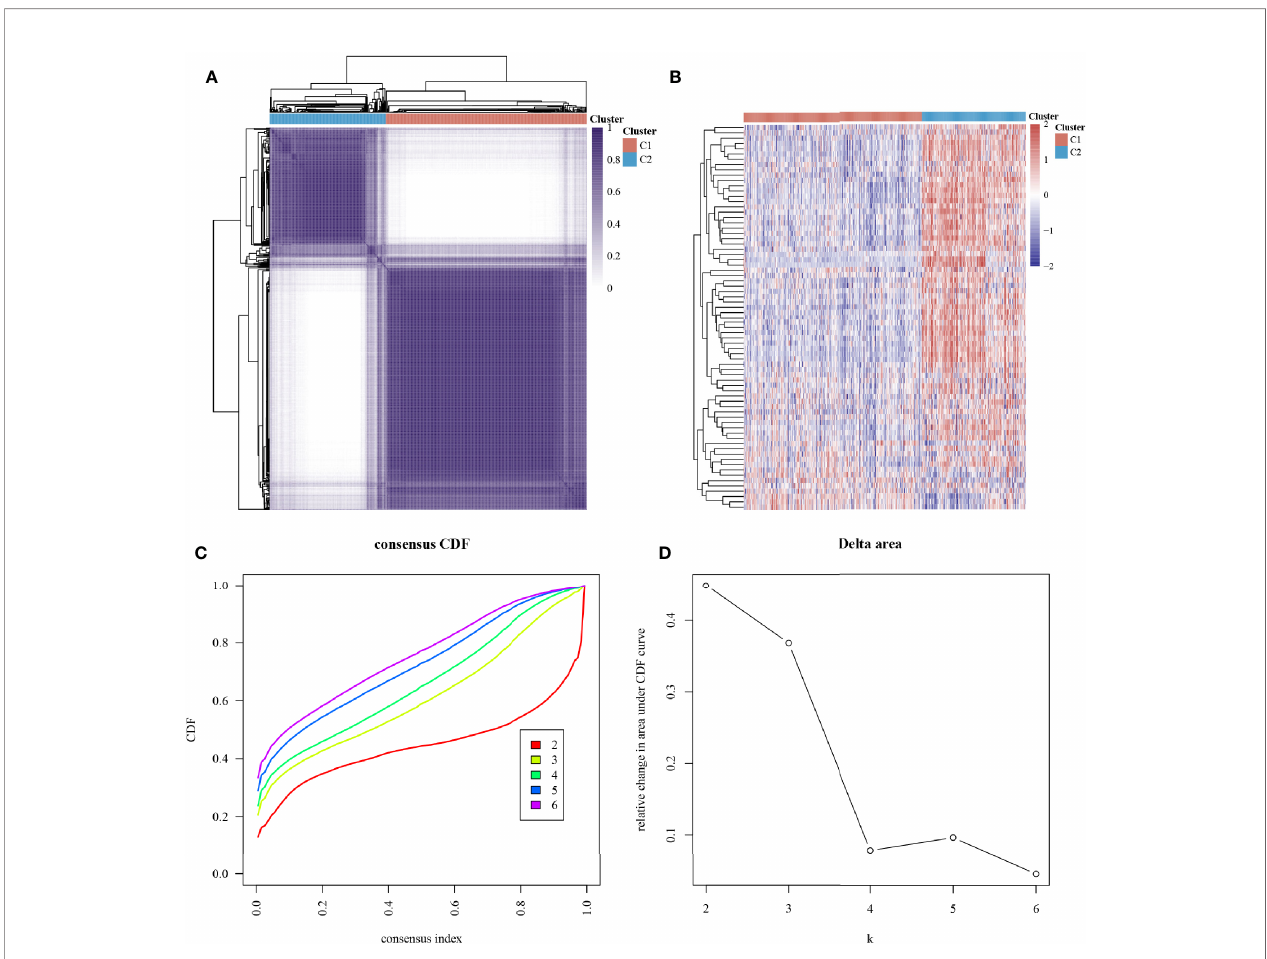
FIGURE 2 | Subtype grouping of 75 hypoxia-associated genes in the TCGA database glioma samples. (A) Consensus clustering matrix at K = 2, (B) ConsensusClusterPlus consistency clustering result heatmap at K = 2, (C) CDF curve at K = 2 – 6, and (D) CDF Delta area curve at K = 2 –